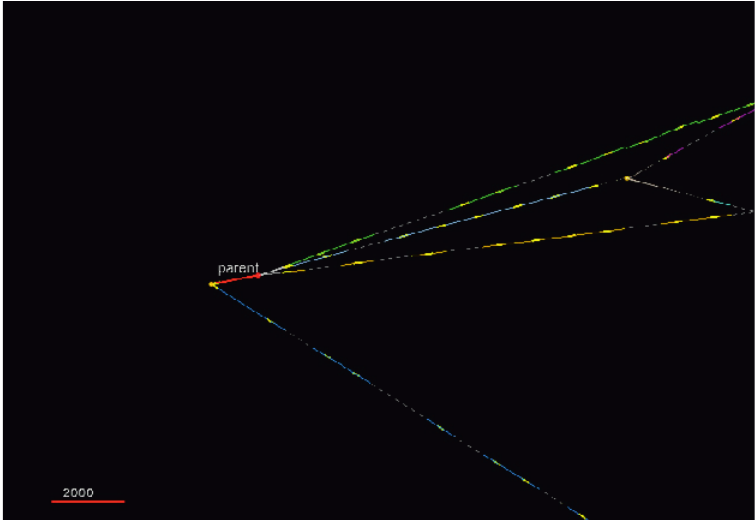
Figure 3. Second tau neutrino candidate event. The τ parent decays in three prongs ( τ → 3 h ), one of them interacts after 10 lead plates.